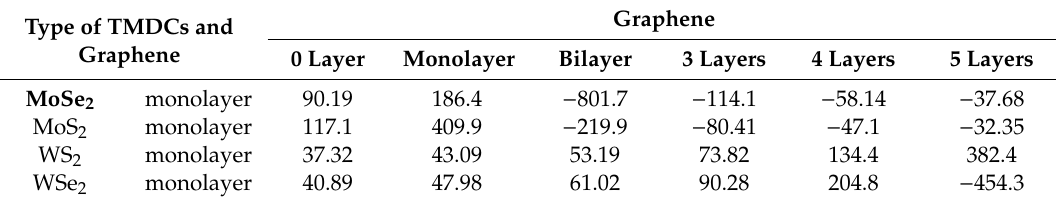
Table 2. Optimized values of di ff erent number of TMDCs and graphene layers with corresponding change in GH shift (S / λ